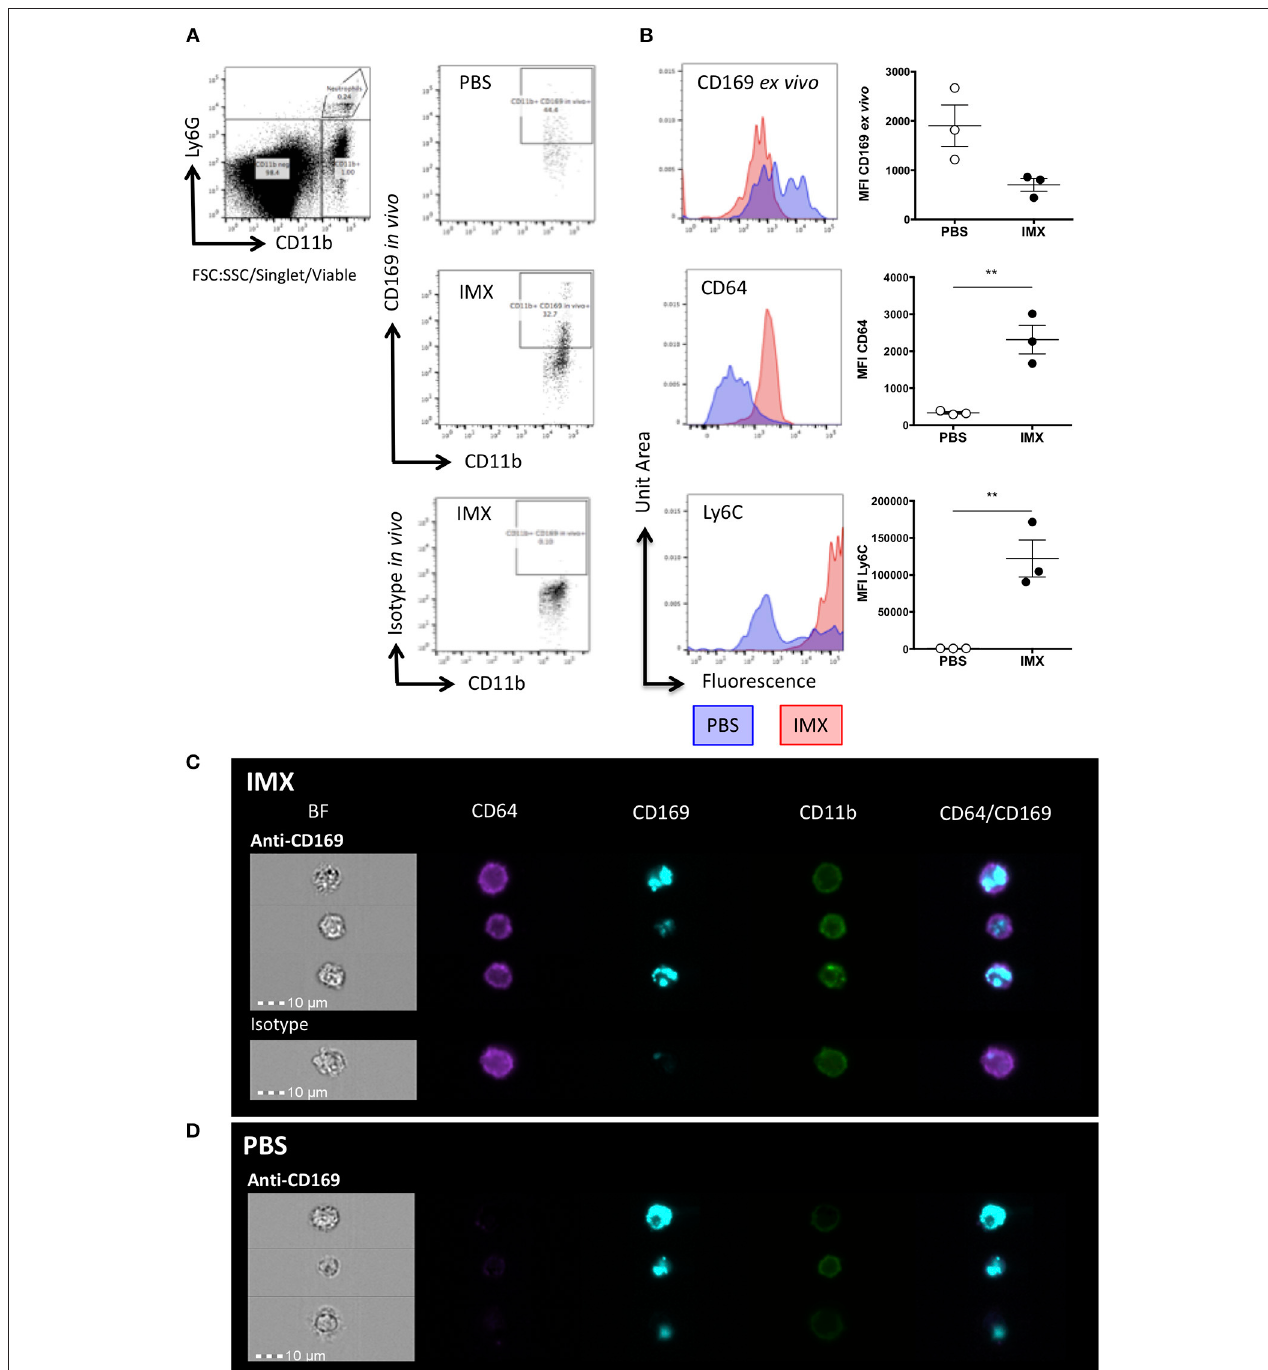
FIGURE 5 | SCS macrophages are taken up by monocytes following immunization with ISCOMATRIX. (A) Representative flow cytometry plots showing in vivo antibody staining with eFluor660 conjugated anti-CD169 prior to treatment with PBS (top) and ISCOMATRIX (middle) or the isotype control antibody (bottom) treatment in the ear pinnae. (B) Representative histograms and MFI (points = individual animals, lines show mean ± SEM) of ex vivo PE conjugated anti-CD169 (top); anti-CD64 (middle), and anti-Ly6C (bottom) on cells positive for the in vivo CD169 label. Groups contained 3 animals and data is representative of two independent experiments ** P < 0.01. (C) Representative imaging flow cytometry images showing monocytes at 24h post-immunization with ISCOMATRIX from the lymph nodes of mice following in vivo eFluor660 conjugated anti-CD169 (top) or the isotype control (bottom) labeling. (D) Representative imaging flow cytometry images showing macrophages (CD11b + ) at 24h post-immunization with PBS from the lymph nodes of mice following in vivo eFluor660 conjugated anti-CD169 labeling. The anti-CD169 antibody treated group contained 3 animals, while the isotype control treated group contained 2 animals. IMX = ISCOMATRIX TM adjuvant.